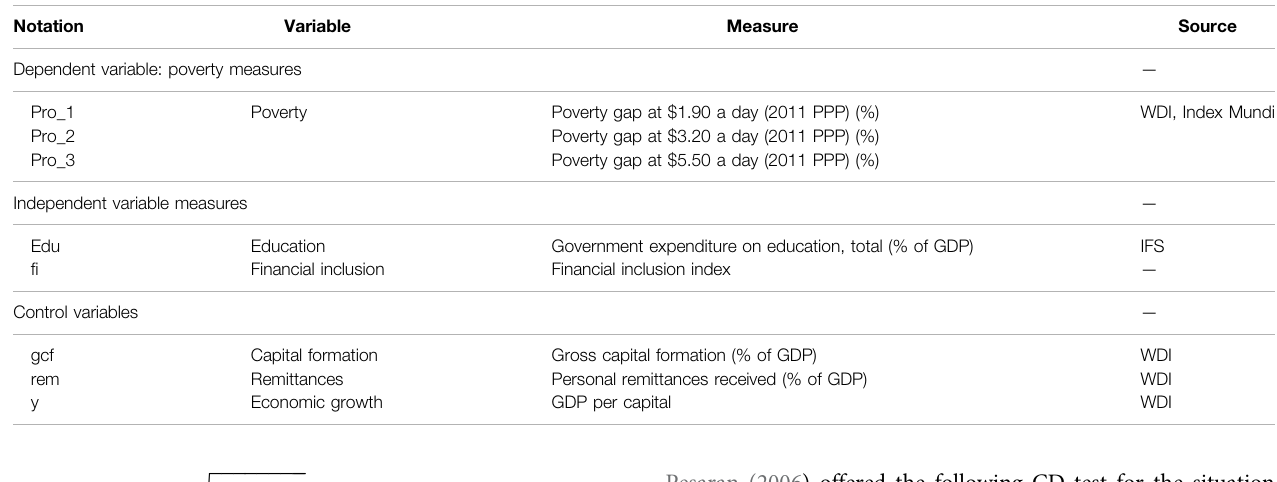
TABLE 4 | Variable de fi nition and data